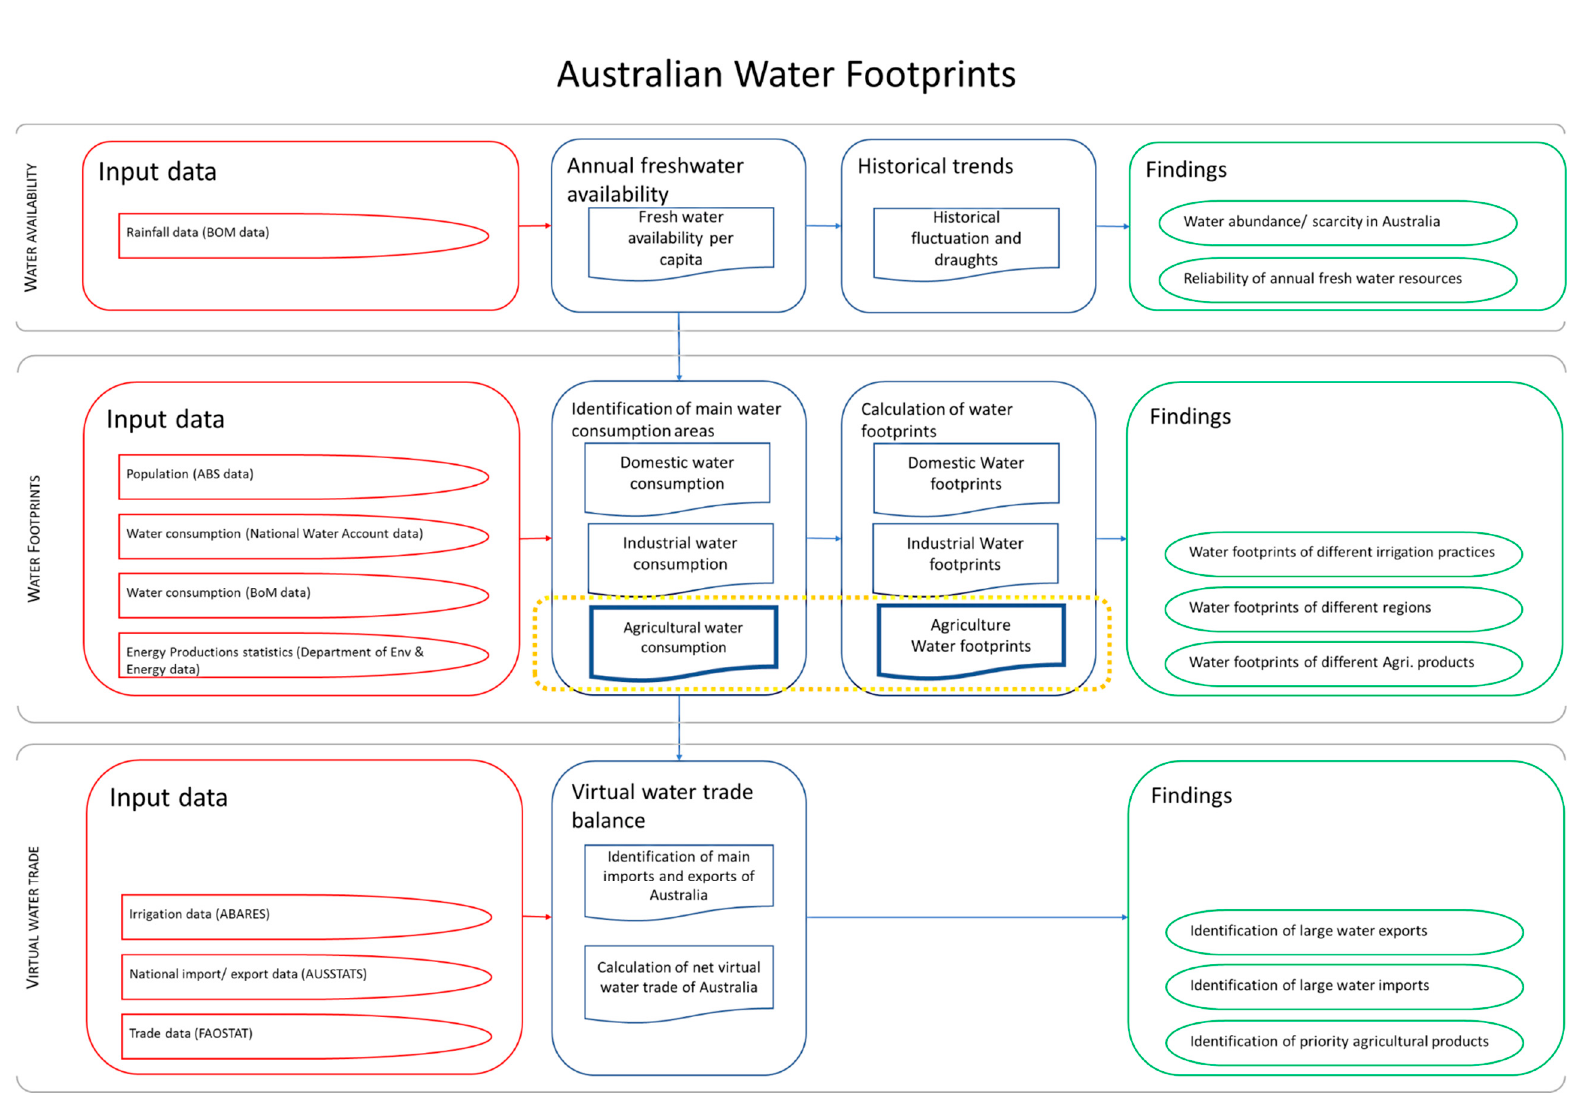
Figure 2. Flowchart of the methodology.